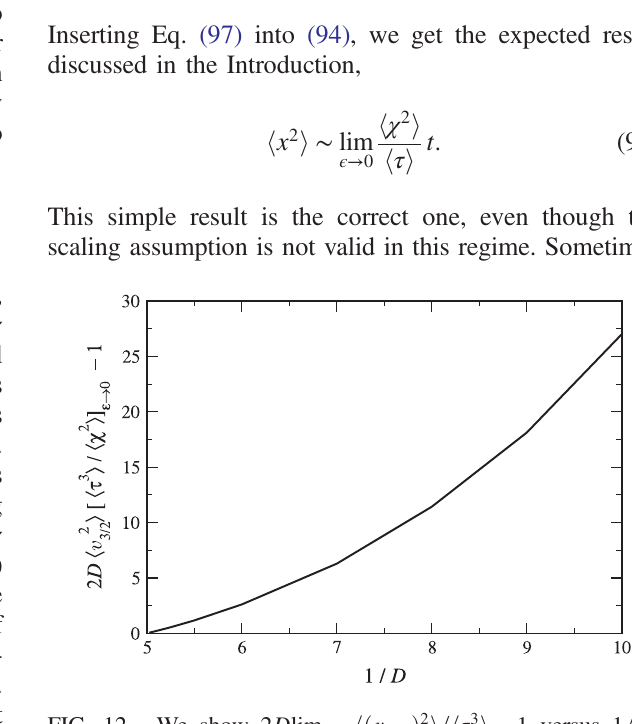
2 i = h τ 3 i − 1 versus 1 =D , FIG. 12. We show 2 D lim ϵ → 0 hð v 3 = 2 Þ which is zero if scaling holds, and D < 1 = 5 . We see that scaling holds only when D → 1 = 5 , which marks the transition from normal to the Lévy type of diffusion. For D > 1 = 5 , scaling holds since then h χ 2 i and h τ 3 i